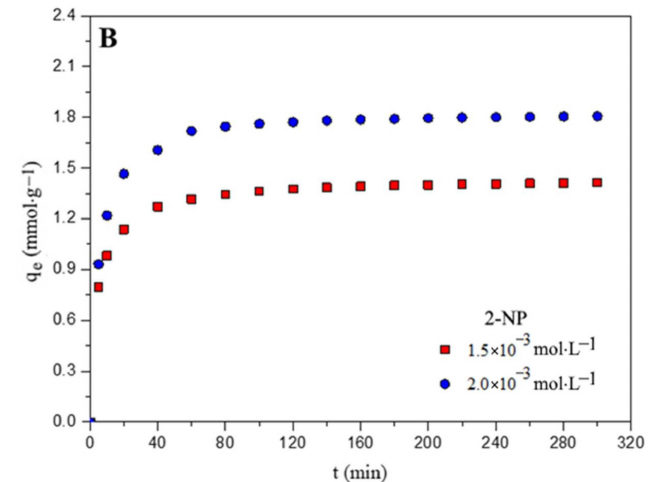
Figure 1. Effect of contact time on the adsorption of phenol, 2-NP and 4-NP on DKLAAC at 25 ◦ C ( A ) and effect of initial concentration on adsorption of 2-NP on DKLAAC at 25 ◦ C ( B ). An initial concentration of 2 × 10 − 3 mol · L − 1 was chosen for the study in ( A ), while two initial concentrations (1.5 × 10 − 3 and 2.0 × 10 − 3 mol · L − 1 ) were selected for 2-NP adsorption in ( B